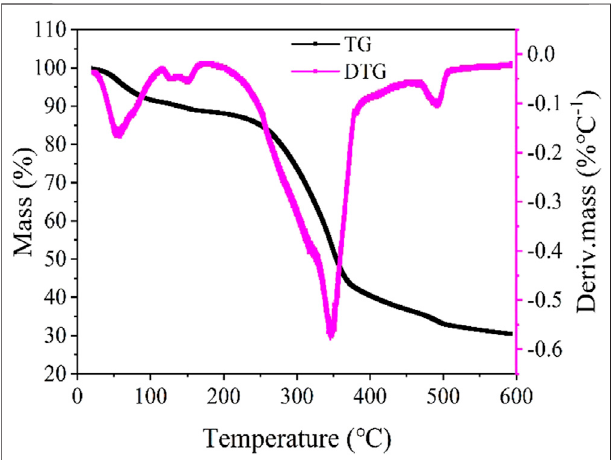
FIGURE 1 | TG analysis curves for